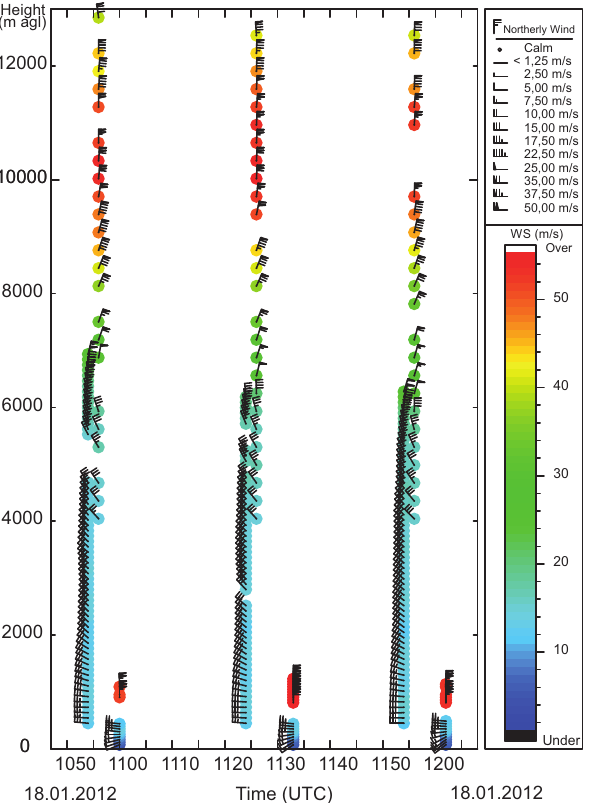
Figure 12. Comparison of three pairs of wind profiles obtained from Doppler lidar measurements and wind profiler measurements, respectively, at three different time slots around 11:00, 11:30 and 12:00UTC on 18 January 2012. For each time the wind profiler measurements are to the left and the Doppler lidar measurements are to the right. The wind profiler measurements are obtained for two different modes, i.e. a lower one providing wind measurements from 450m up to 9380m and a higher one providing additional measurements from about 4000m up to 13000m. The colours indi- cate the wind speed, the wind barbs give further information on the wind